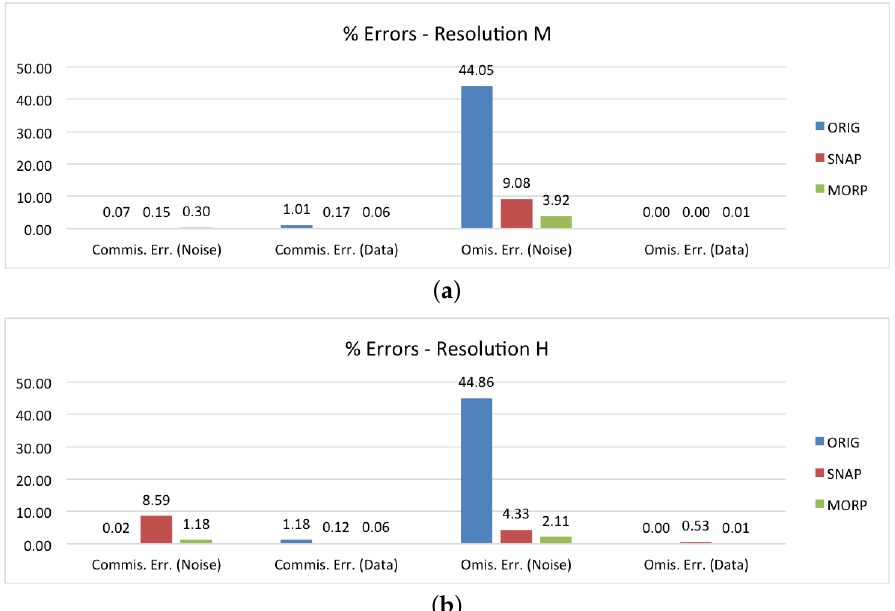
Figure 9. Performance assessment of the proposed method ( MORP ), compared to the original unmasked images ( ORIG ) and the images masked via SNAP’s ‘Remove GRD Border Noise’ module ( SNAP ): ( a , b ) commission/omission errors disaggregated by spatial